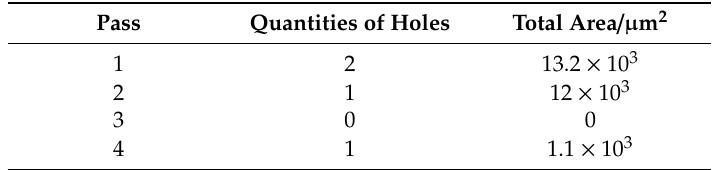
Table 2. Quantities and area of holes in the repair zone for 1060Al / Q235 composite plate after FSP with di ff erent